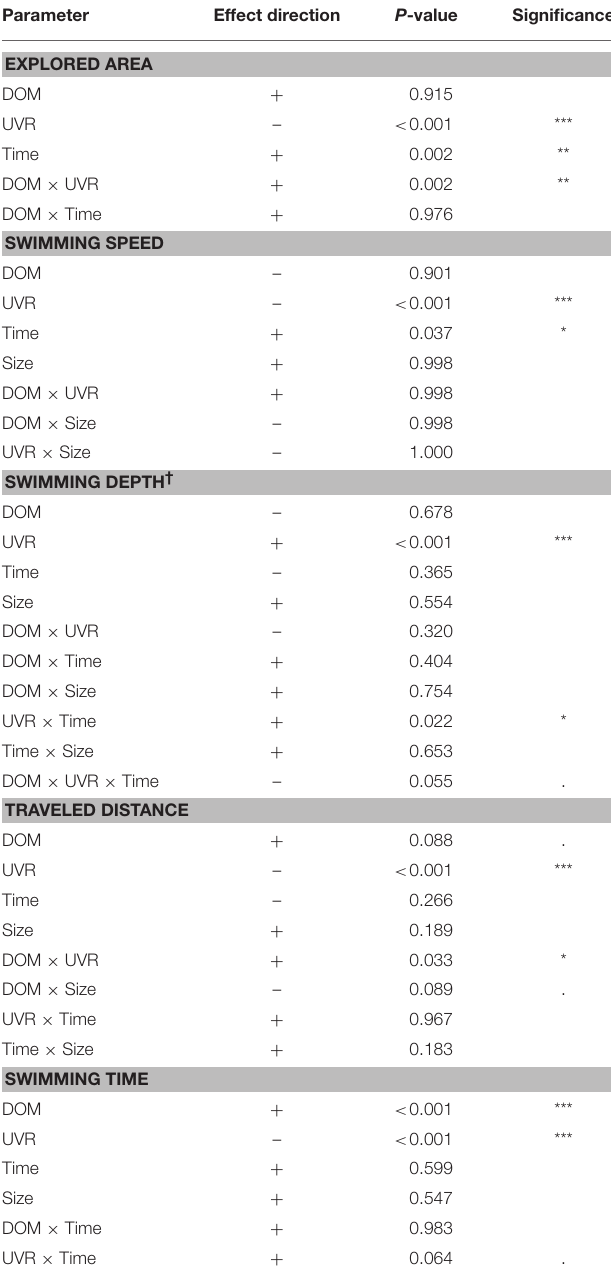
TABLE 1 | Overview of the results from model averaging for the five different behavioral parameters: explored area, swimming speed, swimming depth, traveled distance, and swimming